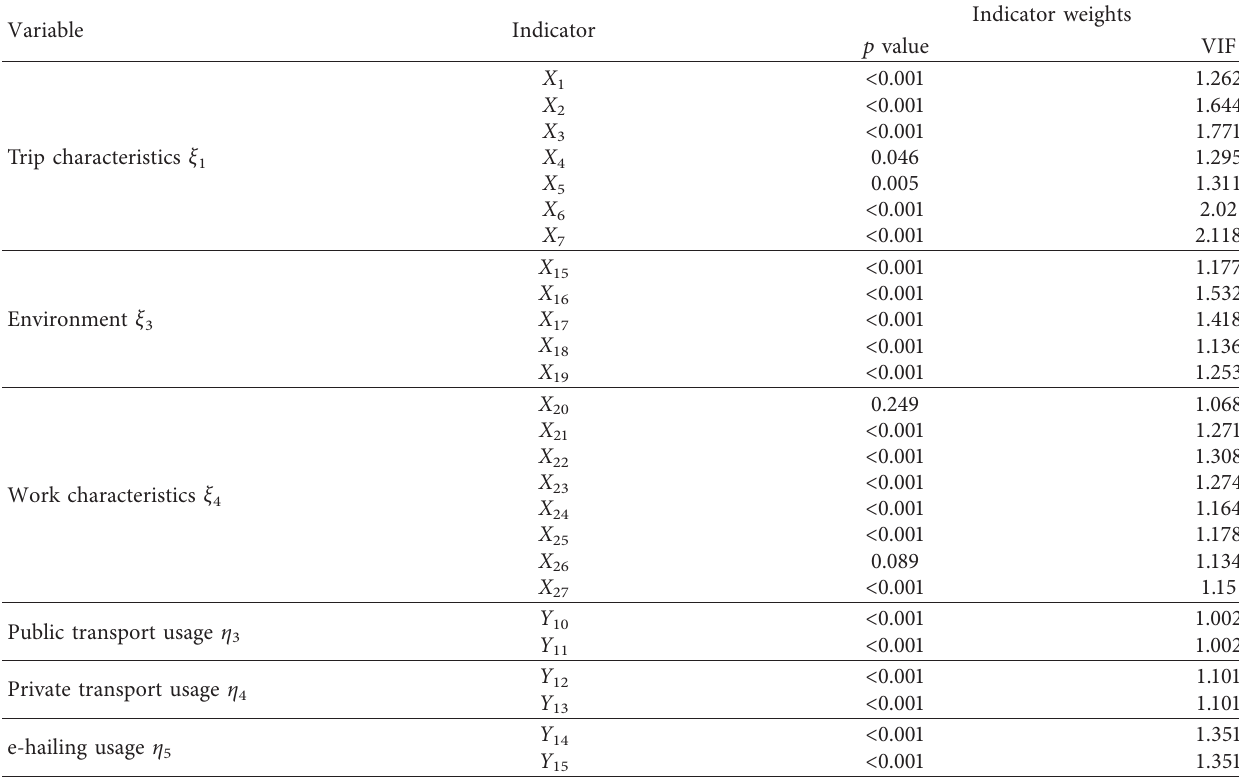
Table 5: Indicator weights for formative variables.